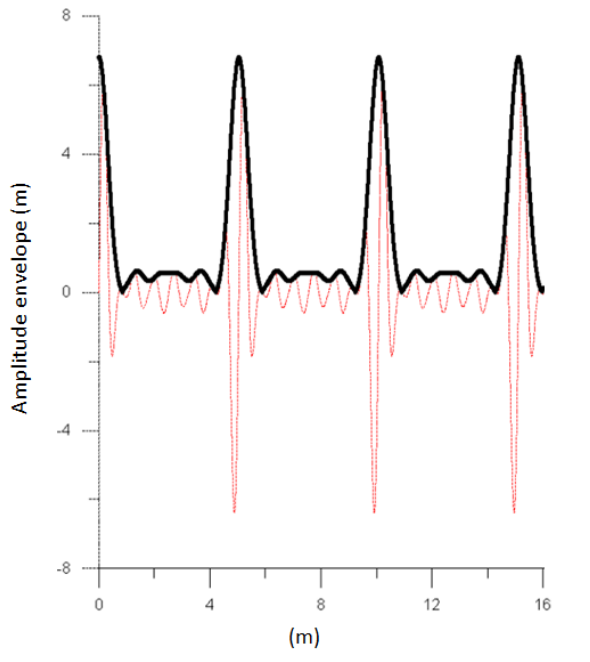
Fig. 8. Amplitude envelope (in black) of the wave train. The hori- zontal axis (abscissa) is in units of our wave tank. The ordinate units are in the scale of the model